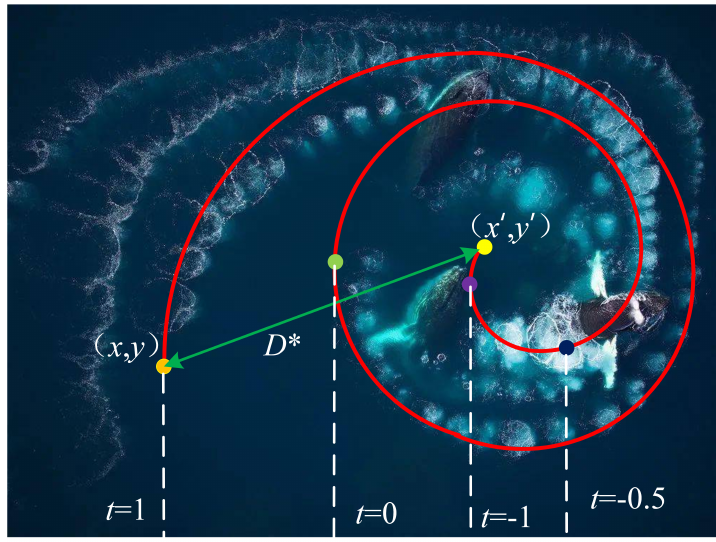
Figure 3. Process of spiral updating of